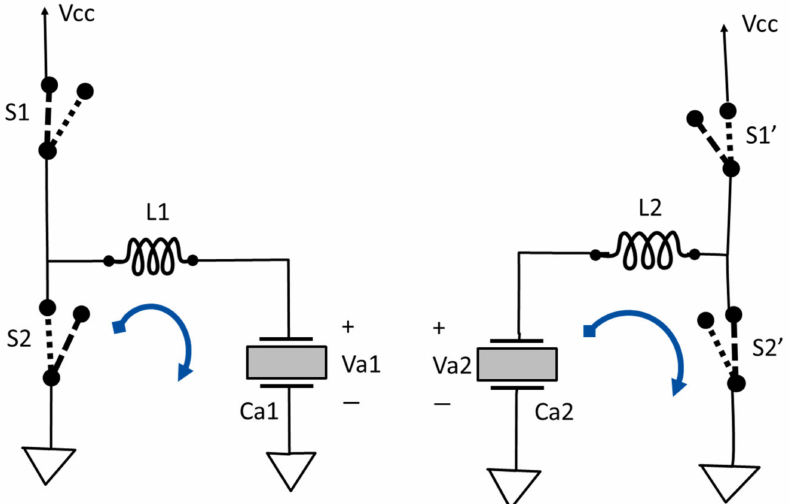
Figure 3. The complementary PWM signals applied to S1 and S2 allow the capacitance of the actuator 1 to charge by gradually increasing the ON time of S1 and OFF time of S2. Similarly, the same complementary PWM signals applied to S2 (cid:48) and S1 (cid:48) allow the capacitance of the actuator 2 to discharge by gradually increasing the ON time of S2 (cid:48) and OFF time of S1 (cid:48) .